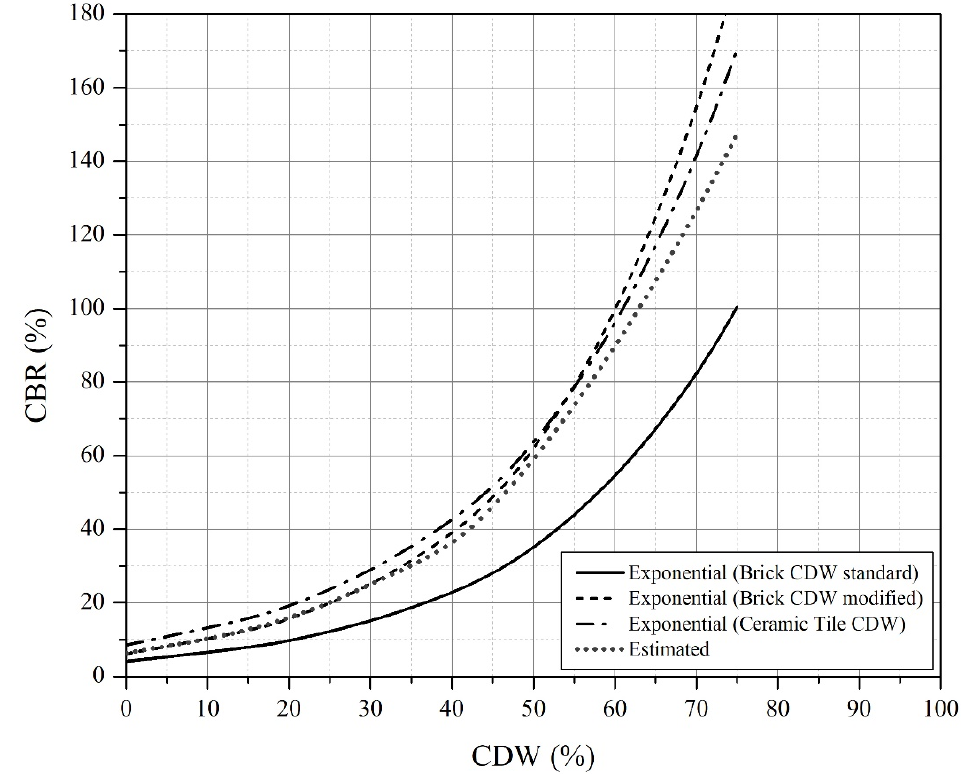
Figure 11. CBR estimation results based on CDW content.